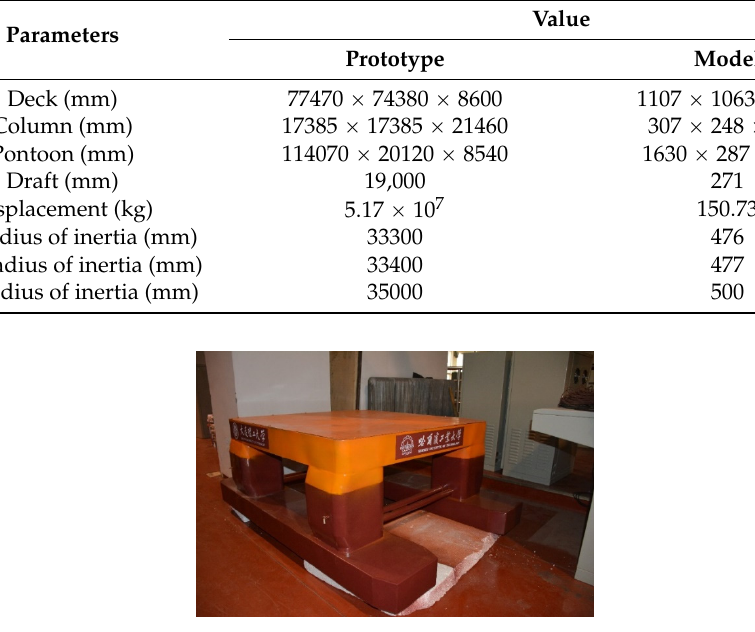
Figure 6. The picture of the scale model of the semi ‐ submersible platform.